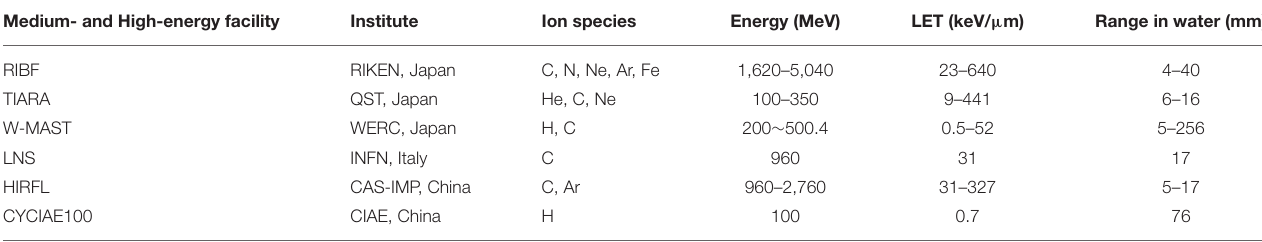
TABLE 1 | Particle accelerator facilities that can be used for radiation